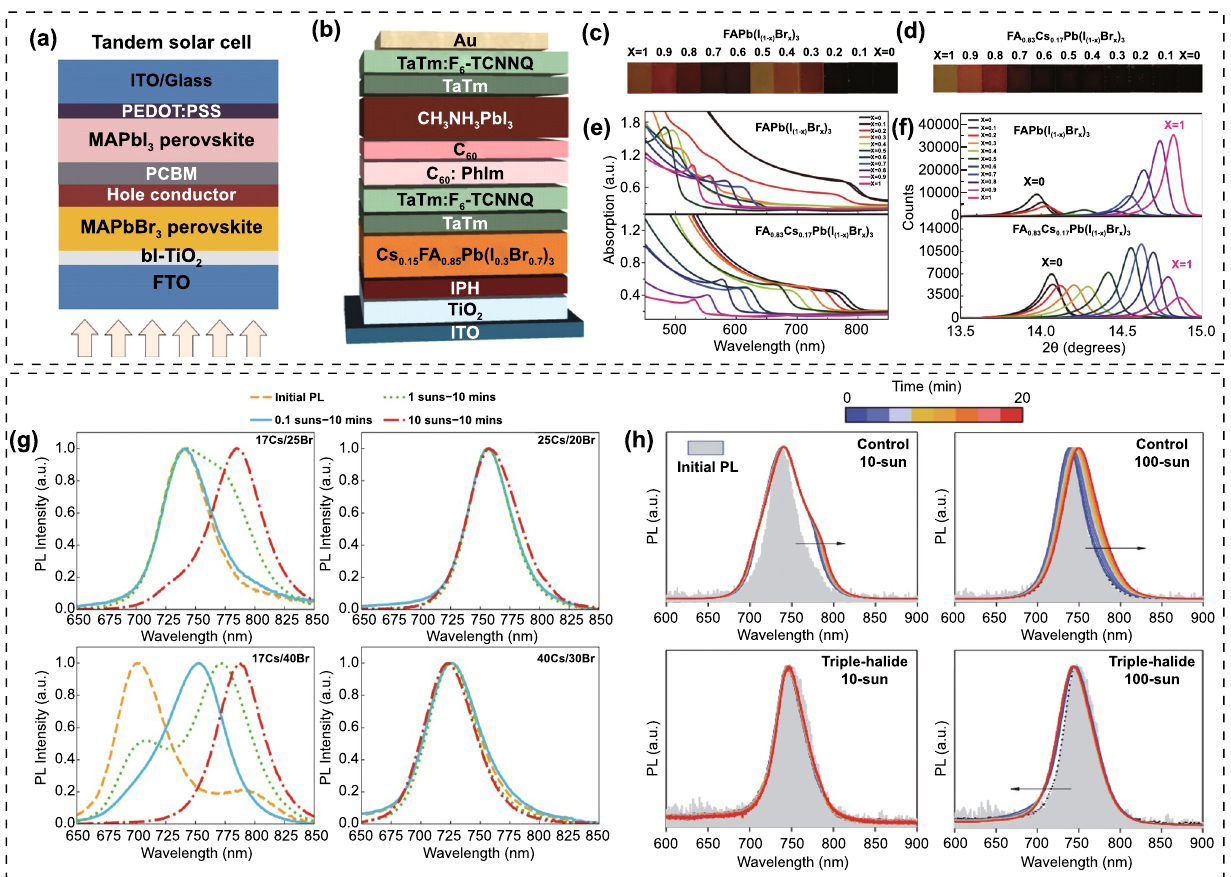
Fig. 4 a Device structure of MAPbBr 3 -MAPbI 3 2-T tandem cell. Reproduced with permission from Ref. [86]. Copyright 2016, Wiley–VCH. b Device structure of Cs 0.15 FA 0.85 Pb(I 0.3 Br 0.7 ) 3 -MAPbI 3 2-T tandem cell. Reproduced with permission from Ref. [93]. Copyright 2017, Wiley– VCH. Photographs of perovskite films with Br composition increasing from x = 0 to 1 for c FAPb[I (1-x) Br x ] 3 and d FA 0.83 Cs 0.17 Pb[I (1-x) Br x ] 3